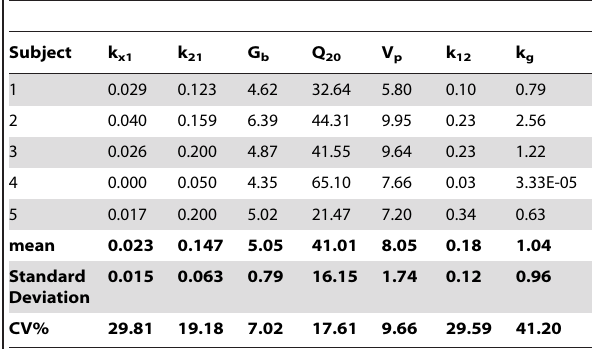
Table 3. Parameter estimates for the two-compartment model for glycemia